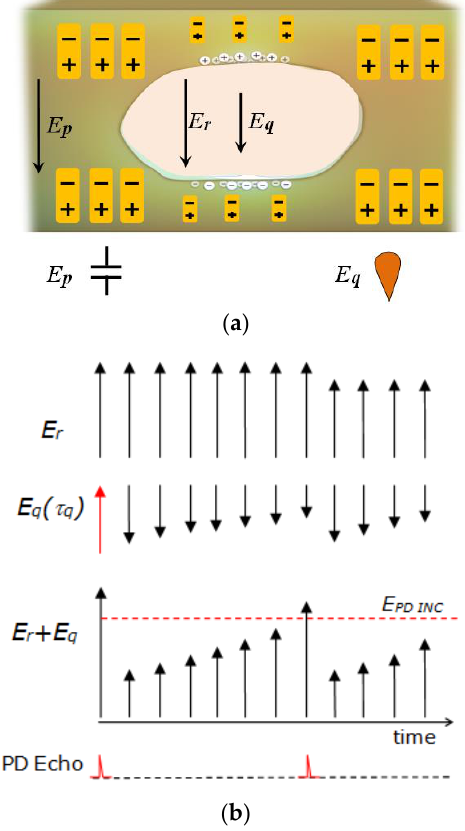
Figure 2. Interplay of electric fields in a void. ( a ) Illustration of the void stress at the transition point T 0 , being the superposition of polarization, and E q field (illustration for a case when no PDs are present, just before the T 0 in the sinusoidal part), ( b ) visualization of the remnant and accumulated field